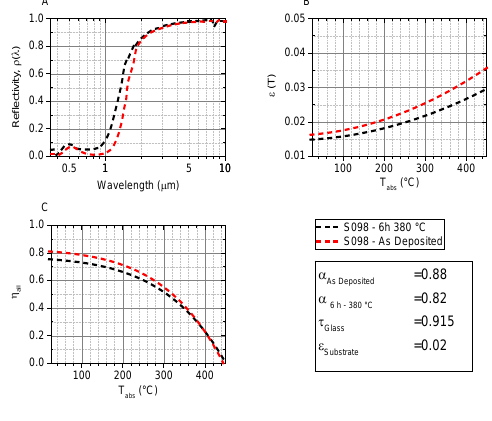
Fig. 2 : Measured spectral reflectance of solar selective coating optimized to work at 300 °C before and after heating in vacuum at 380 °C for 6 hours. The The obtained results indicate that multilayers are an excellent solution to achieving high efficiency with good thermal stability in HVFP collectors, contributing to the desired renewable energy